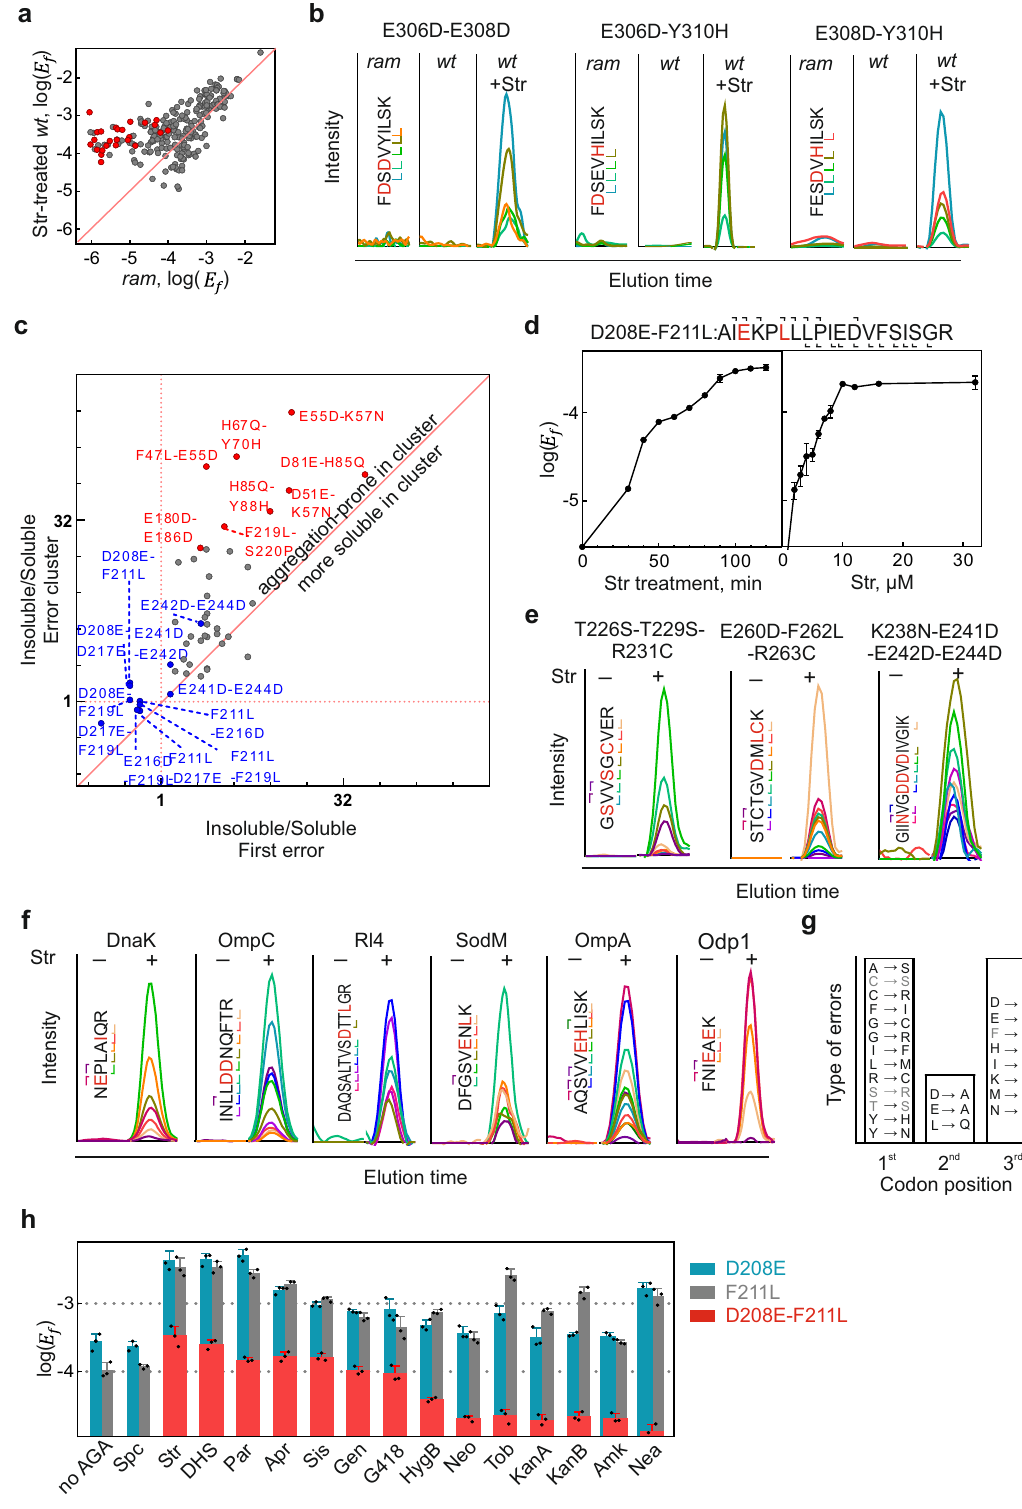
NATURE COMMUNICATIONS| (2021) 12:1830